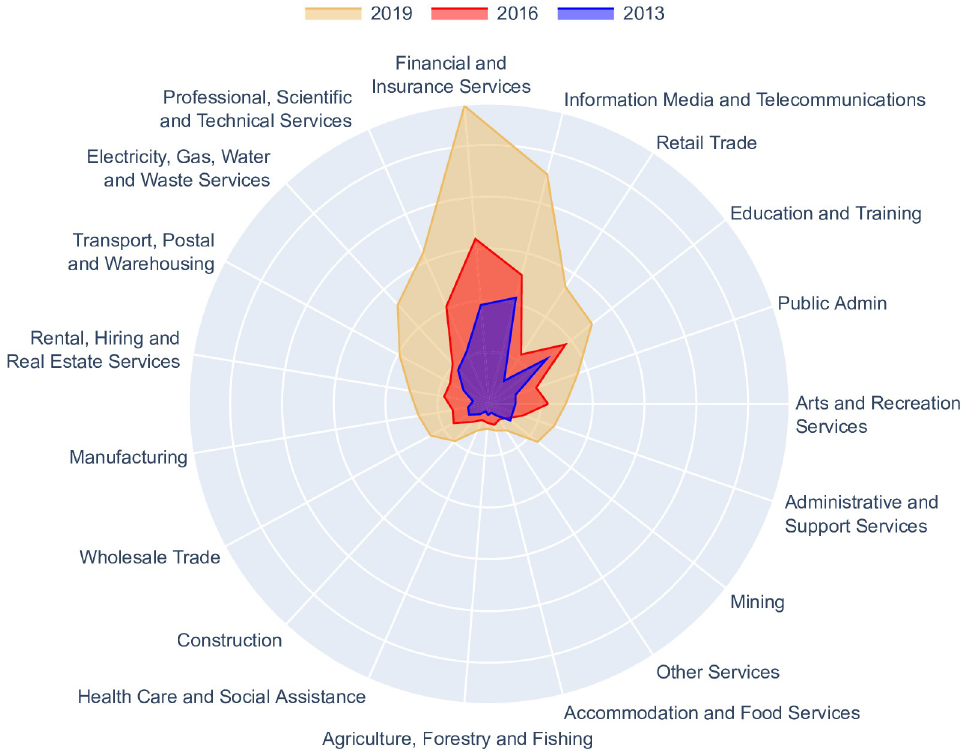
Fig 6. By applying S KILLS S PACE , we measure the yearly similarities between adaptive sets of AI skills against each of the 19 Australian industries from 2013–2019. As industry skill sets become more similar to AI skills, the colored area of the radar chart expands. All industries have increased their similarity levels to AI skills, albeit at different rates. We argue that higher levels of AI similarity indicate AI skills are becoming more important to firms within an industry and that the skills gap to acquiring AI skills is narrowed. Access to these skills accelerates the rate of firms adopting AI and making productive use of the technologies, which offers a leading indicator of AI adoption and potential labor disruptions within these